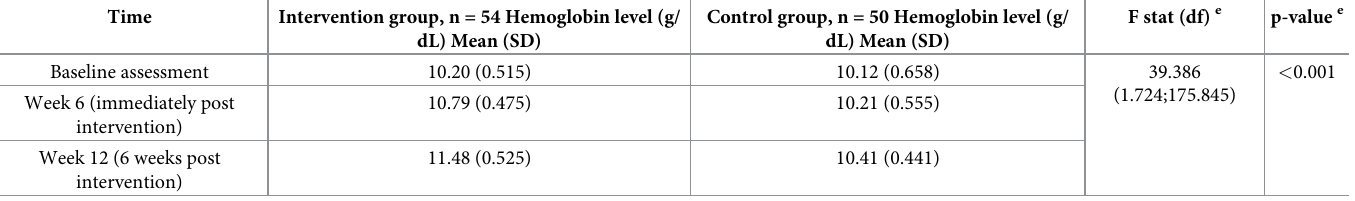
Table 6. Changes in hemoglobin over time between intervention and control group.